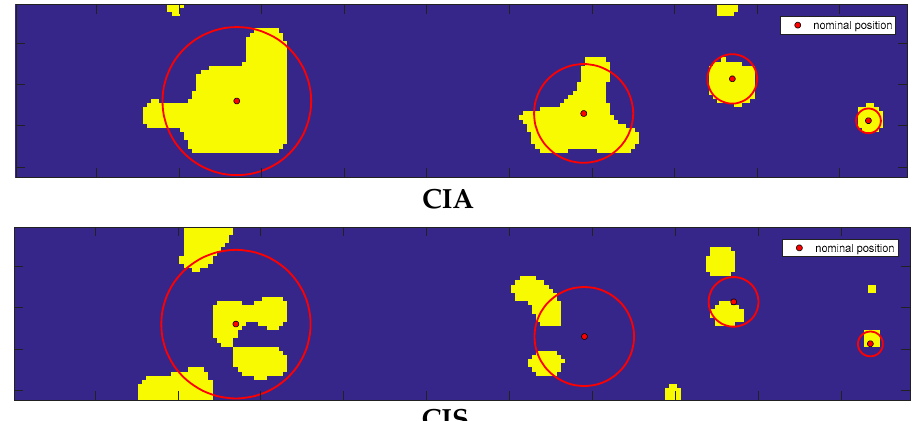
Figure 5. Map of inclusions on an area of 72 mm × 14 mm corresponding to n = 252 scanned points. (Top) CIA map and (Bottom) CIS map. Dimensions of the four inclusions are (from left to right): 12, 9, 6 and 3 mm. Red dots represent the nominal position of inclusions and red circles their dimensions. Yellow color indicates the areas over which the unsupervised classifier algorithm found inclusions while the blue color indicates those where the algorithm did not find inclusions.